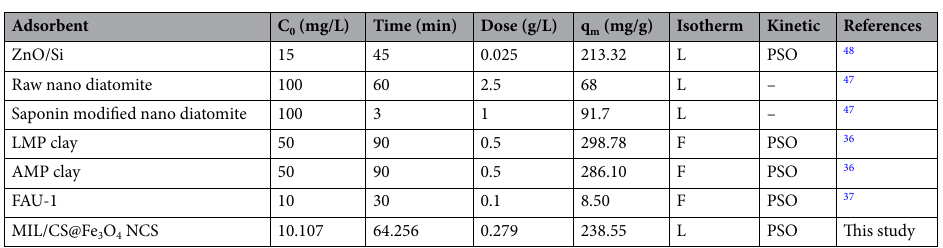
Table 4 . Comparison of AZT adsorption reported in the literature with the proposed systems. L Langmuir, F Freundlich, PSO Pseudo-second-order.